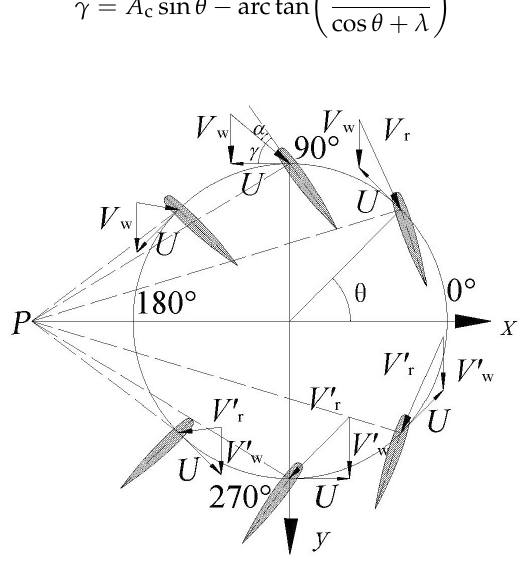
Figure 4. Illustration cycloidal variable pitch.